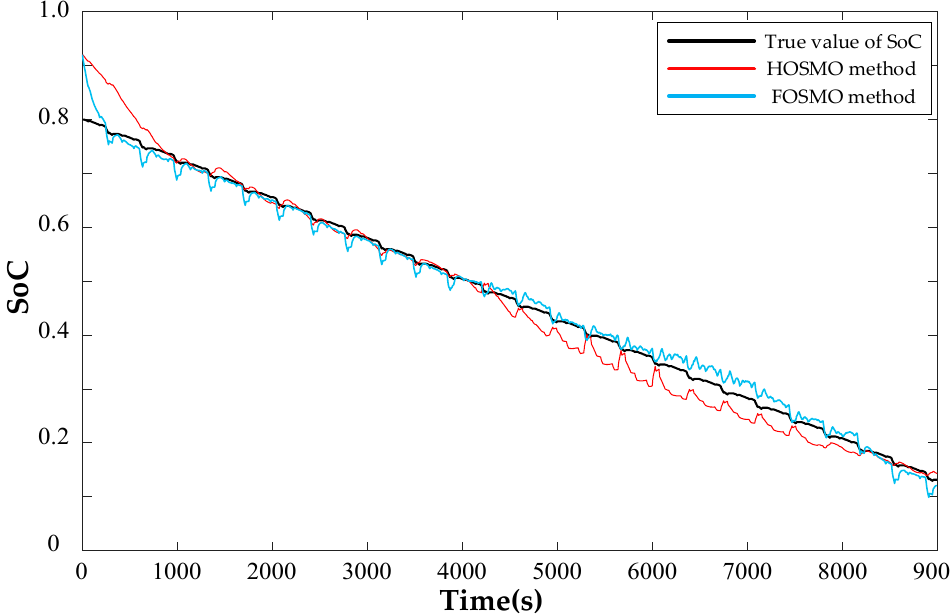
Figure 5. True value of the SoC and the estimated SoC under FOSMO and HOSMO from DST.